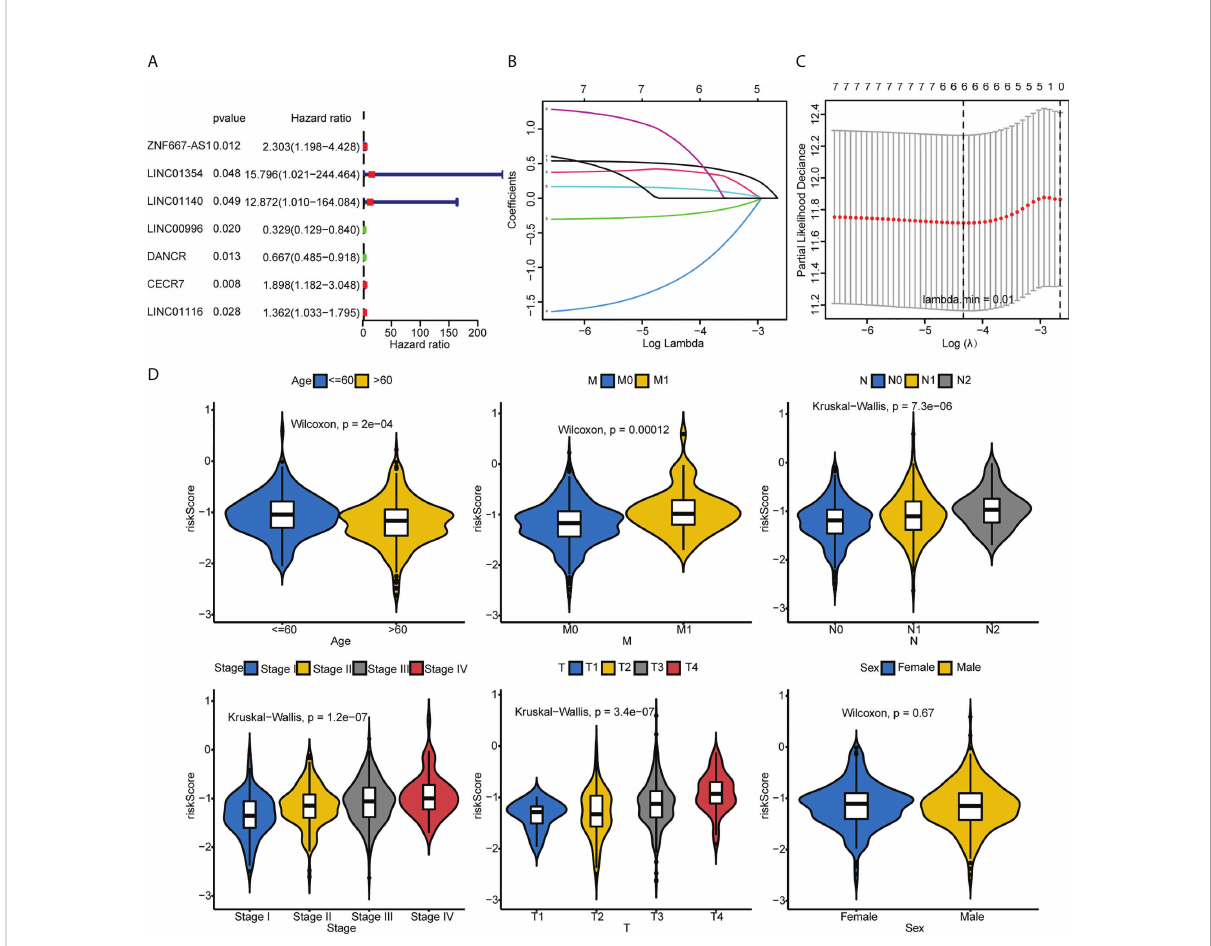
FIGURE 5 Identi fi cation of the hypoxia-immune – related risk signature. (A) Univariate Cox regression analysis of 52 common hypoxia-immune – related DElncRNAs in TCGA. (B, C) LASSO analysis was performed to identify the prognostic signature. (D) Comparison of the risk scores between or among groups strati fi ed by different clinical